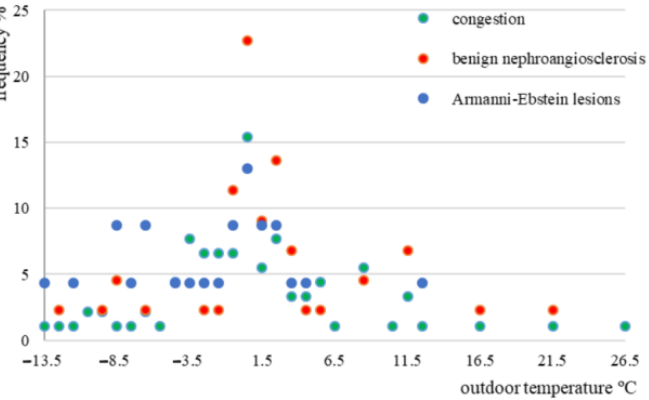
Figure 5. Frequency of cases according to outdoor temperature, congestion, benign nefroangio- sclerosis, and Armanni − Ebstein lesions in the study group.